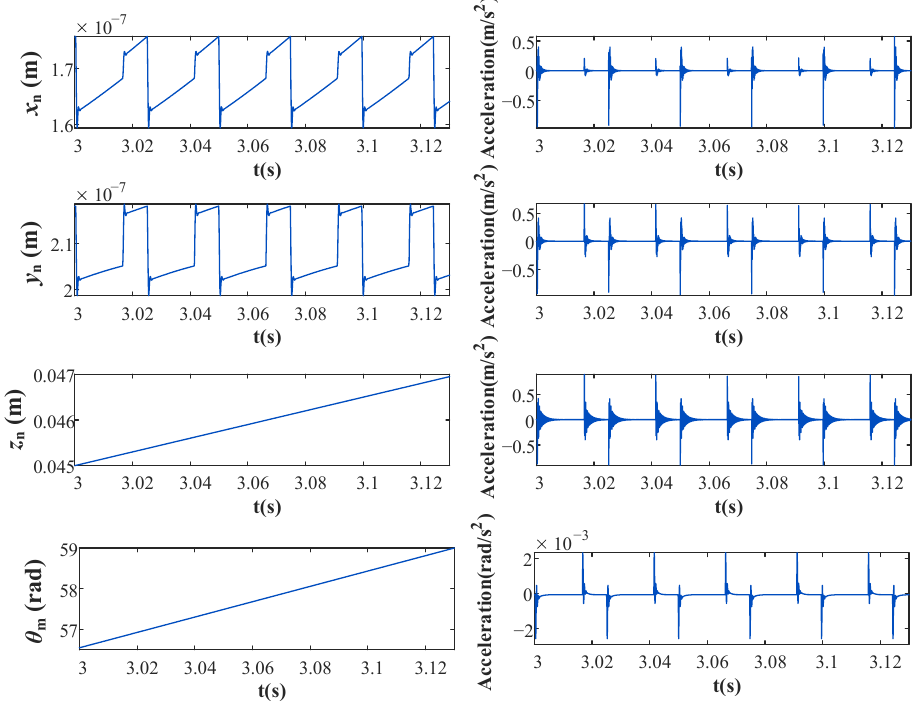
Figure 9. Displacement responses and acceleration responses of the nut or motor output shaft-related parameters under normal conditions.